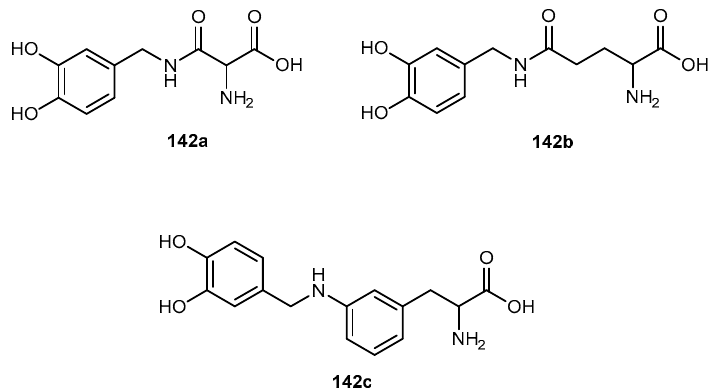
Figure 59. Amino acid prodrugs of 142 synthesized by Peura and co-workers [188].